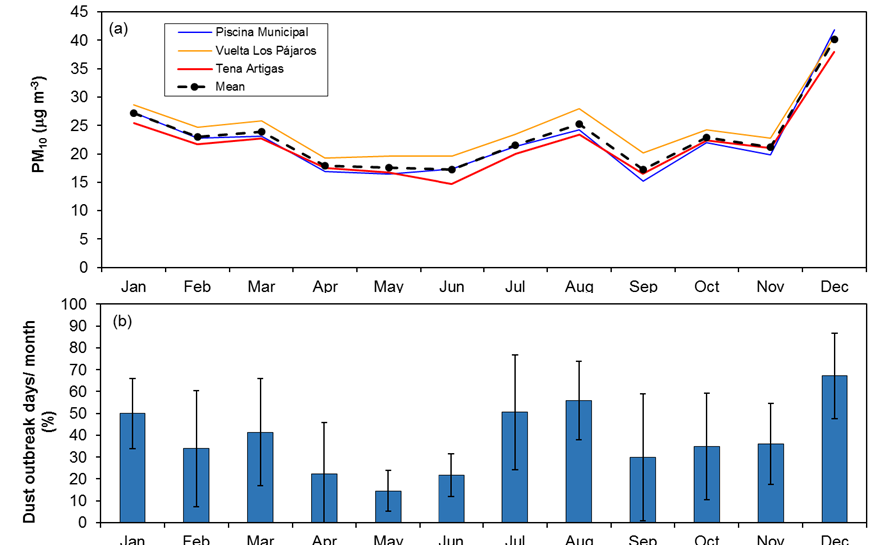
Figure 3. Seasonal variability of ( a ) PM 10 concentrations and ( b ) desert dust outbreaks for 2012 to 2017: The error bars in Figure 3b represent the standard deviation in the mean monthly